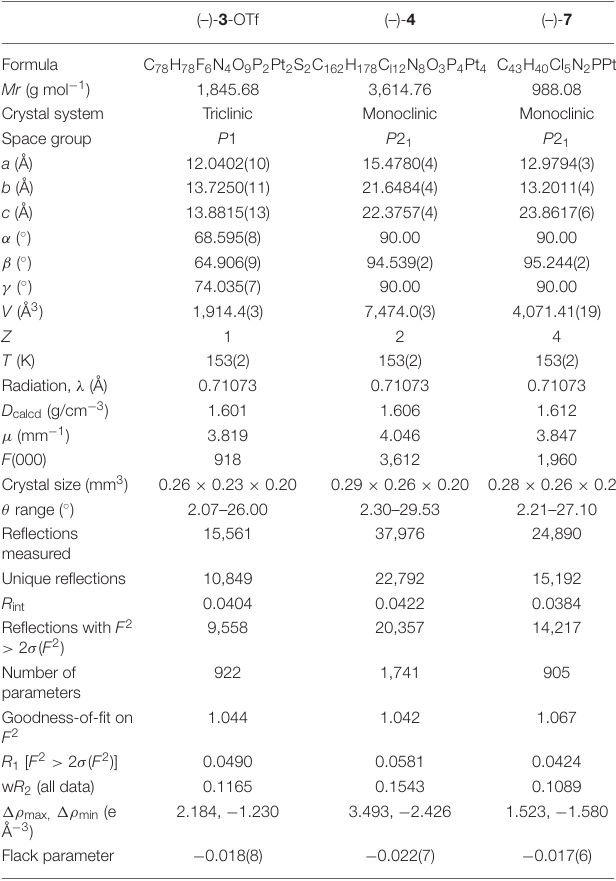
TABLE 1 | Crystallographic data of (–)- 3 -OTf, (–)- 4 , and (–)- 7